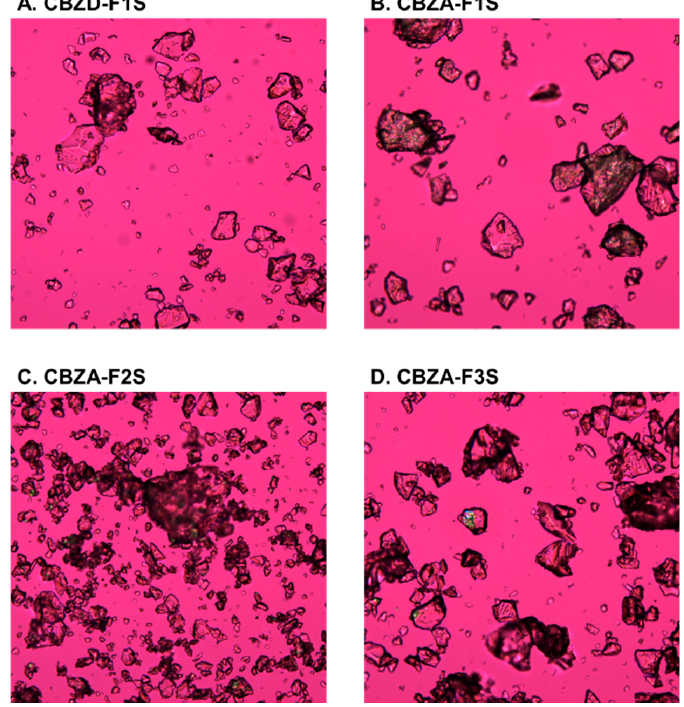
Figure 8. PLM images (100×) of formulations prepared by using screw design 2.